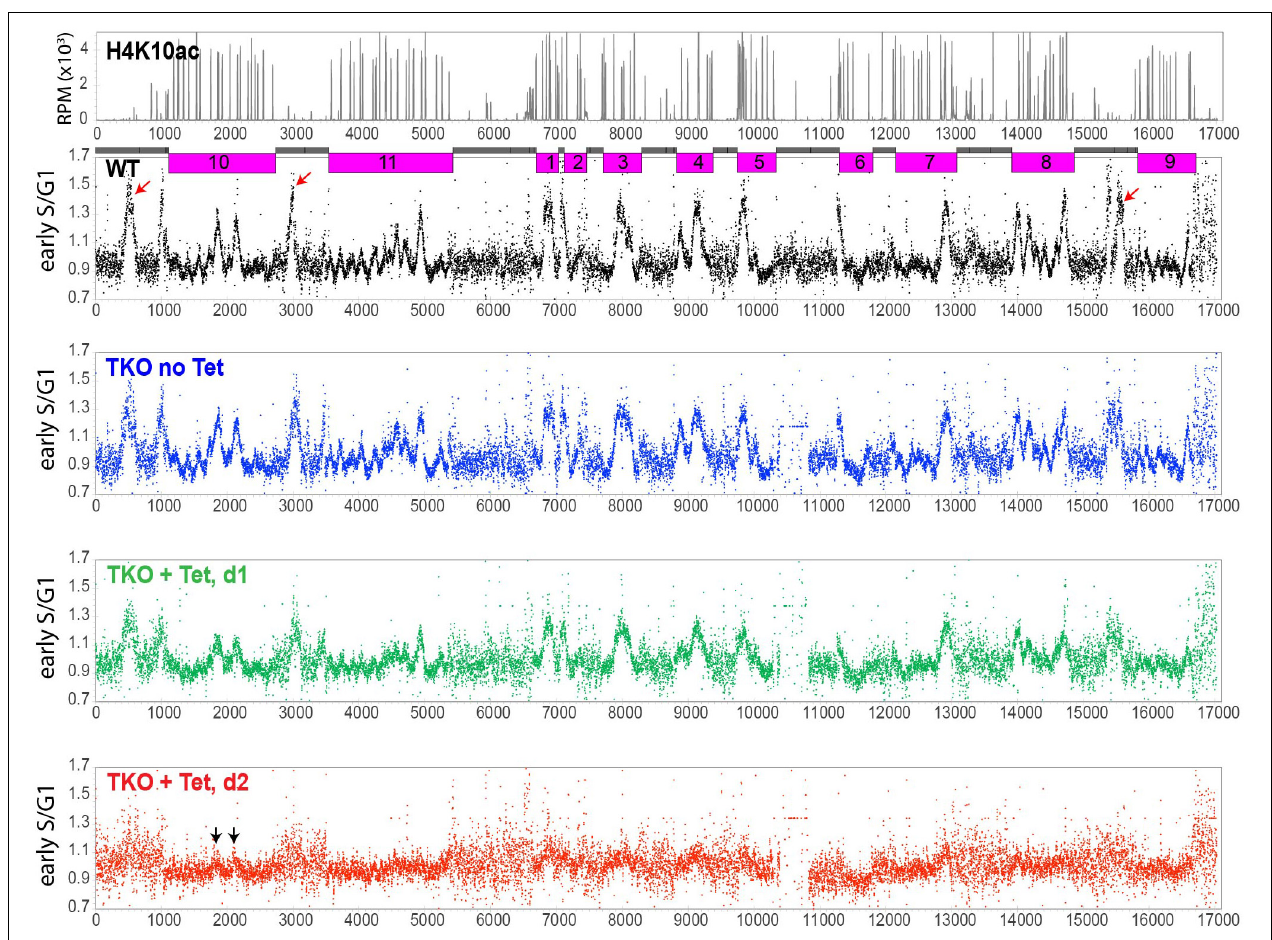
FIGURE 5 | Global DNA replication impairment in TKO cells. Replication was examined by marker frequency analysis followed by high-throughput sequencing (MFA-seq). TKO strain with a floxed H3v-HA allele was treated with tetracycline for 0, 1, or 2 days and stained with PI. Cells in G1, early S, late S, and G2 phase were FACS-sorted ( Supplementary Figure 8C ). Genomic DNA was prepared and sequenced in the Illumina platform. Sequence reads were aligned to the Lister 427 genome and analyzed with sliding window (10-kb bin, 2.5-kb step). Read count ratio between early S to G1 was plotted for the whole genome, including subtelomeric regions. Chromosome cores (pink) and subtelomeres (gray) in the chromosome diagram are shown. Several of early replicating origins occur in subtelomeres of chromosomes 10, 11, and 9 (red arrows in the WT plot). MFA-seq reads obtained from WT (Kim, 2019) were re-analyzed and mapped to the Lister 427 genome for comparison. Subtelomere 6A of chromosome 6 has been lost in the TKO